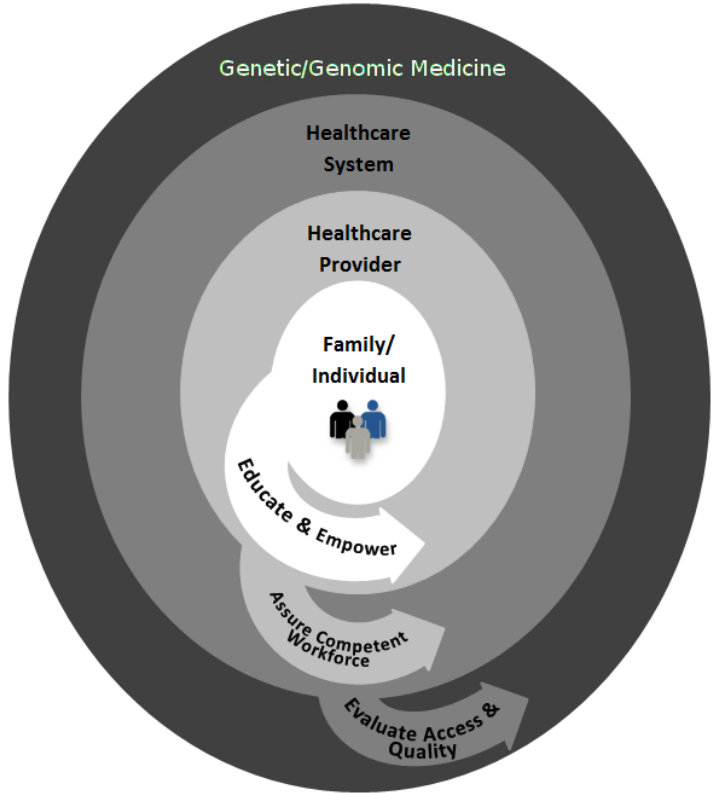
Figure 1. Engagement in public health functions (illustrated by the arrows) at multiple levels can help to achieve the population health benefits of genetic and genomic medicine.